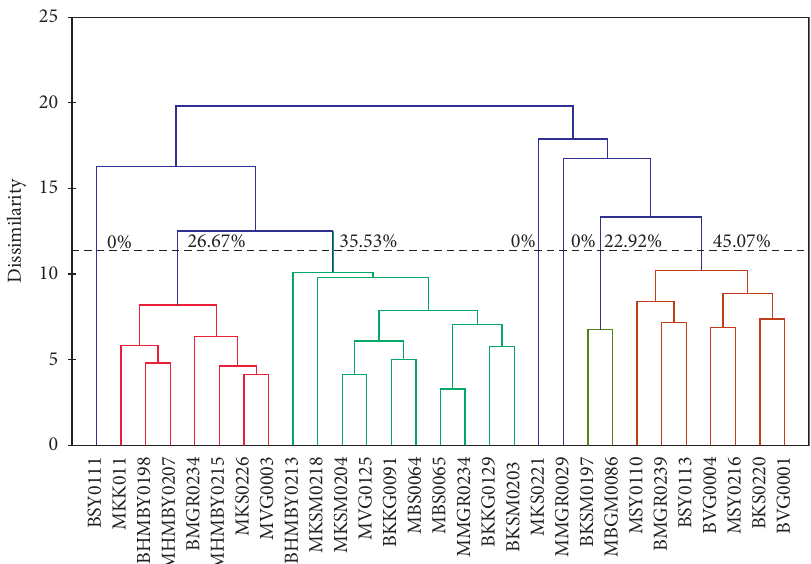
Figure 2: Dendrogram showing morphological diversity of 29 accessions of Crotalaria spp . The figures at the truncation line show the percent diversity within different supported clusters.